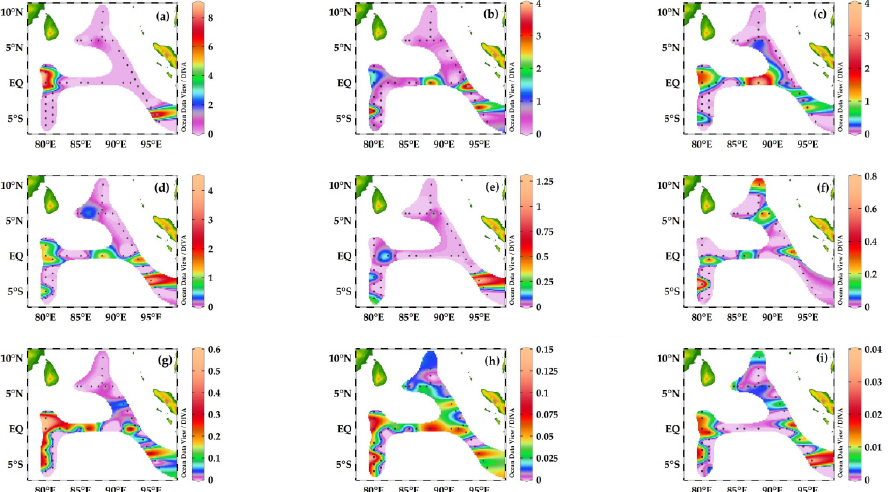
Figure 7. Horizontal distribution of total carbon biomass/station ( µ g C m − 3 ) of the foraminiferal species in the Eastern Indian Ocean. ( a ) Globorotalia menardii ; ( b ) Globigerinoides ruber (white); ( c ) Globigerinella calida ; ( d ) Orbulina universa ; ( e ) Globigerinella glutinata ; ( f ) Trilobatus sacculifer ; ( g ) Globigerinella siphonifera ; ( h ) Globigerina bulloides ; ( i ) Turborotalita quinqueloba .